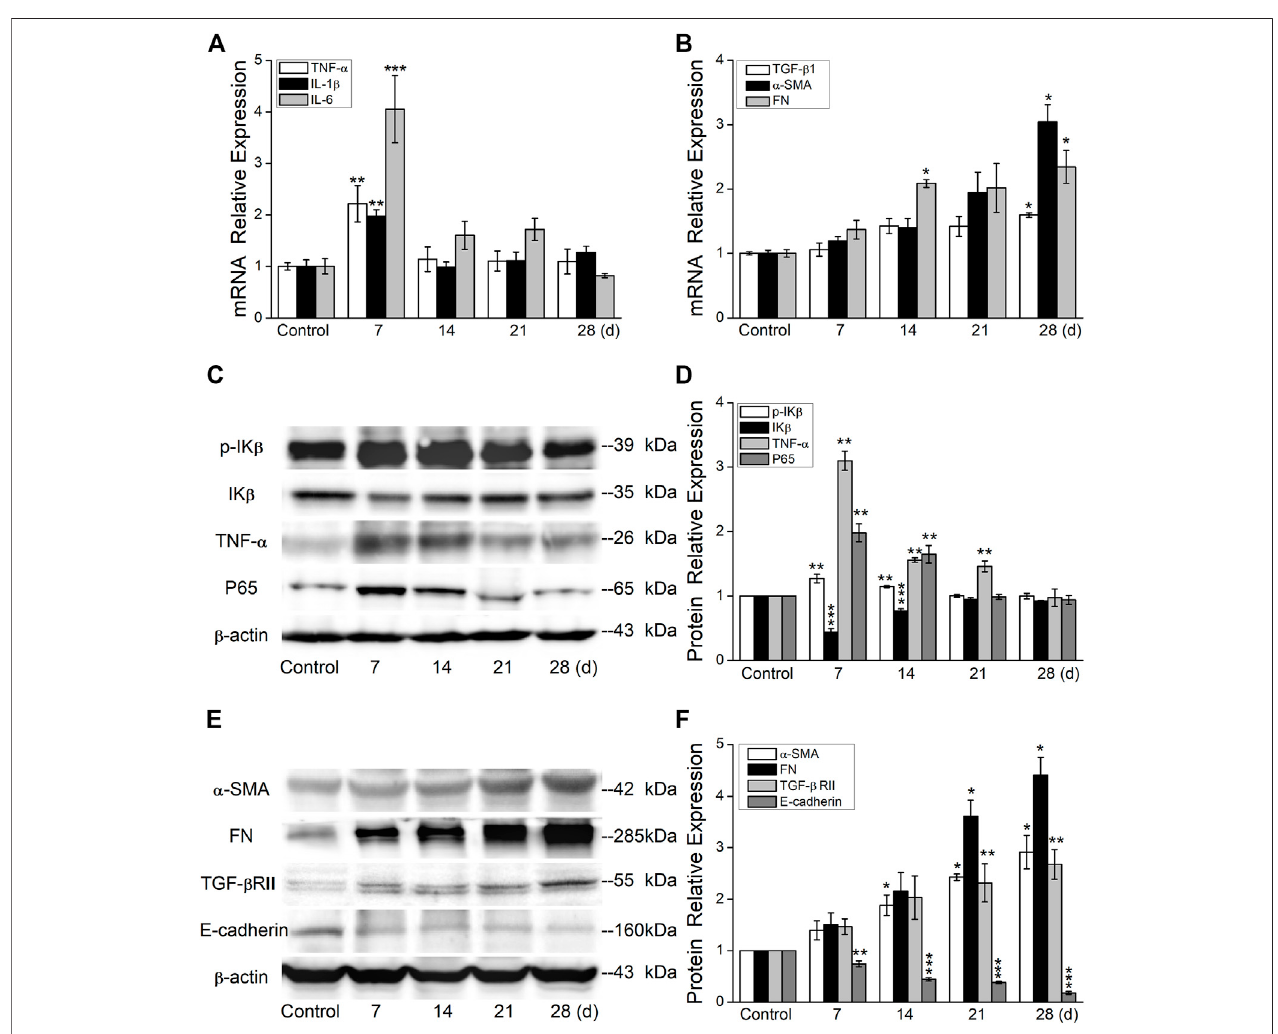
FIGURE 2 | BLM induces the expression of in fl ammation- and fi brosis-related protein. (A) qRT-PCR quantitation of mRNA expressions of in fl ammation-related genes. ** p < 0.01, *** p < 0.001, -versus the control group, one-way ANOVA followed by Bonferroni ’ s test, n = 3 – 6. (B) qRT-PCR quantitation of mRNA expressions of fi brosis-related genes. * p < 0.05, versus the control group, by the Mann – Whitney U test, n = 3 – 6. (C-D) Representative and statistical data of in fl ammation-related proteins. ** p < 0.01, *** p < 0.001, versus the control group, by the Mann – Whitney U test, n = 4 – 5. (E-F) Representative and statistical data of fi